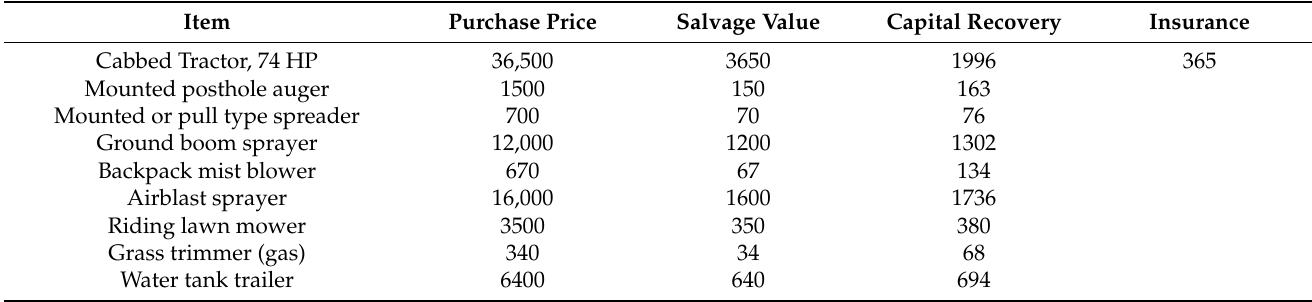
Table 3. List of machinery and equipment considered in the budget for a hybrid cultivar.